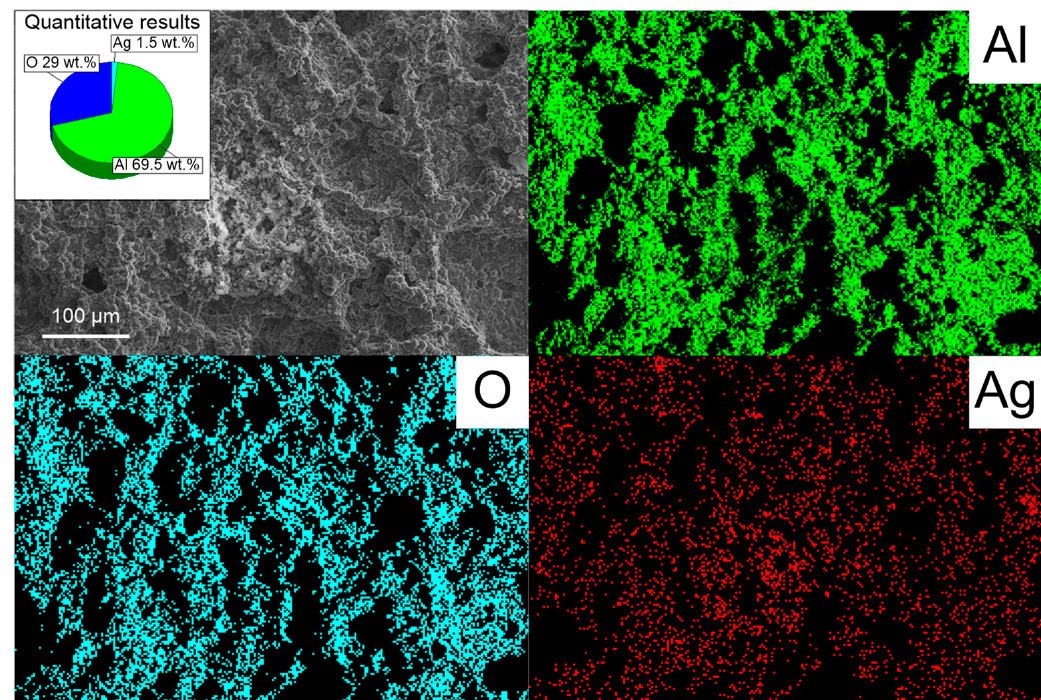
Figure 6. SEM image and elemental mapping EDS analysis of the macroporous ceramics surface modified with AlOOH/Ag nanostructures.